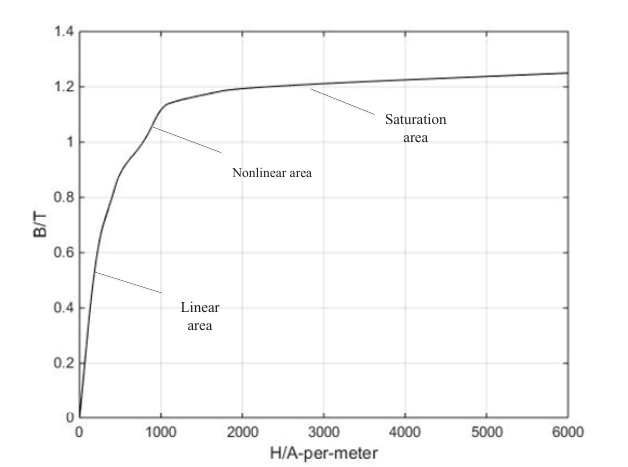
Figure 5. BH curve of the iron block in the torque motor.